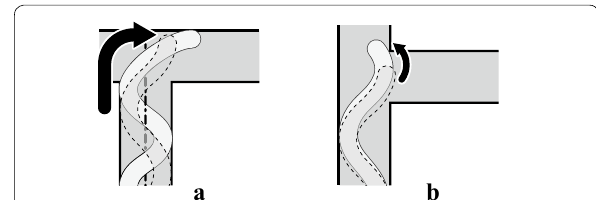
Fig. 6 Locomotion trajectory based on the locomotion pattern illustrated in Fig. 5. In Type A ( a ), the device is deformed by pressing itself against the inner wall of the desired branched pathway. In